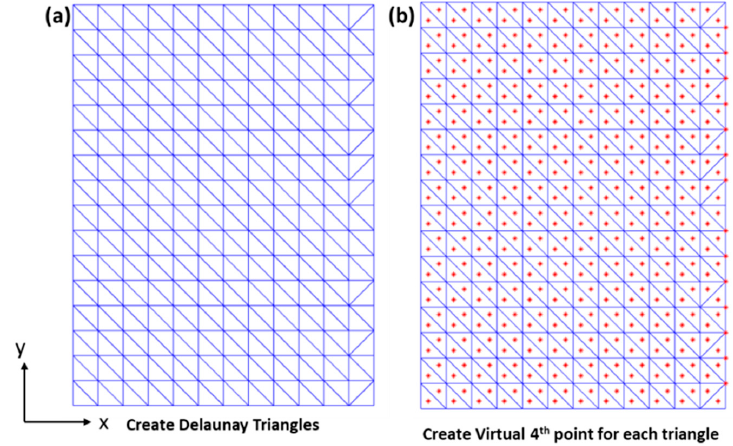
Figure 6. ( a ) Triangular mesh generated using Delaunay Triangular given the coordinates within the region of interest; ( b ) calculating the centroid of the generated triangle as the fourth virtual point for each triangle mesh.